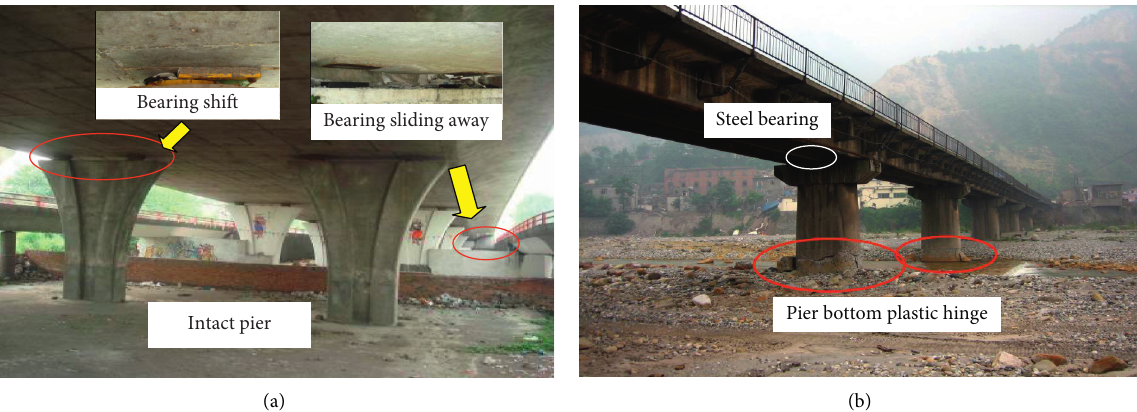
Figure 1: Typical earthquake damages on bridges supported by different types of bearings. (a) Mianzhu Huilan bridge (LRB). (b) Mianzhu Hanwang bridge (steel